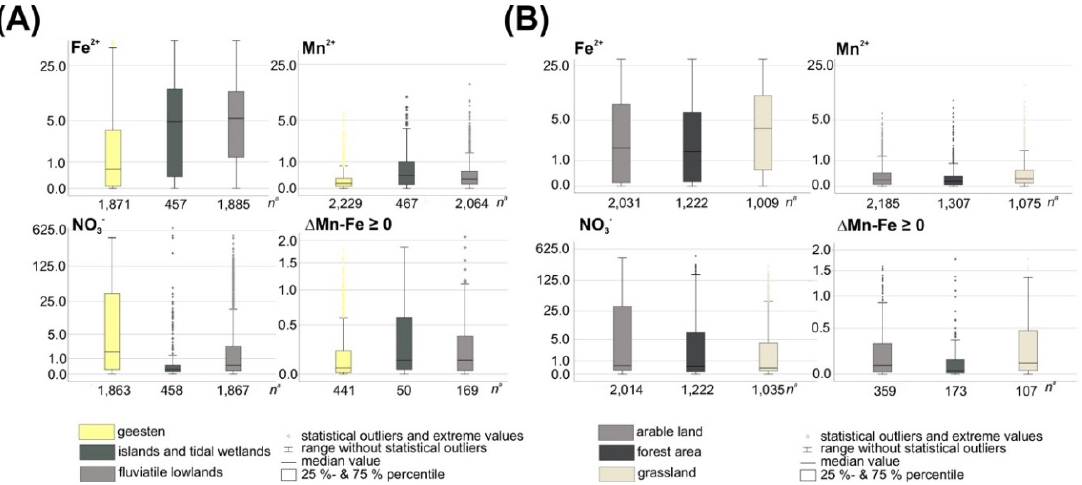
Figure 2. ( A ) Rank statistical distribution of Fe, Mn, nitrate and ∆ Mn-Fe ≥ 0 in the hydrogeological units. ( B ) Rank statistical distribution of Fe, Mn, nitrate and ∆ Mn-Fe ≥ 0 grouped by land use. The x -axis indicates the number of recent analyses per unit. The numbers differ because not all parameter were analyzed in every sample, the y -axis indicates the concentration [log mg/L]. The ∆ Mn-Fe values are only given for ∆ Mn-Fe > 0.